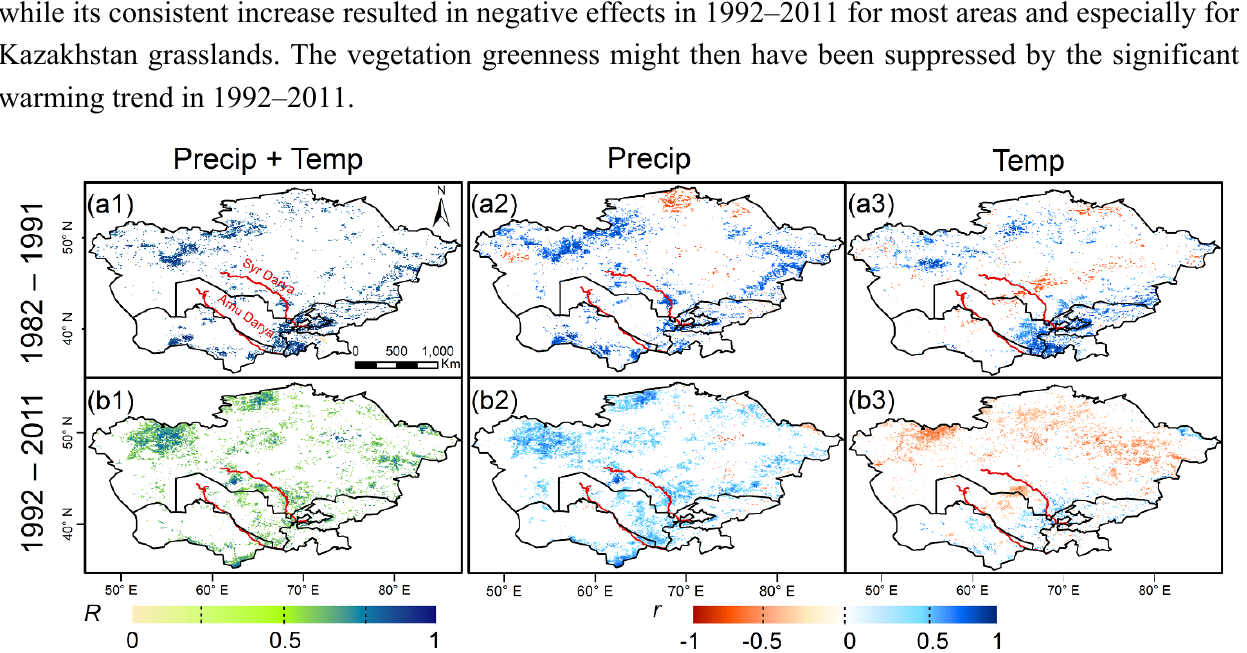
Figure 7. NDVI response to ( a1 , b1 ) combined precipitation and temperature ( R ), ( a2 , b2 ) precipitation ( r ), and ( a3 , b3 ) temperature ( r ) during 1982–1991 and 1992–2011. The areas with significant correlations correspond to a p -value <